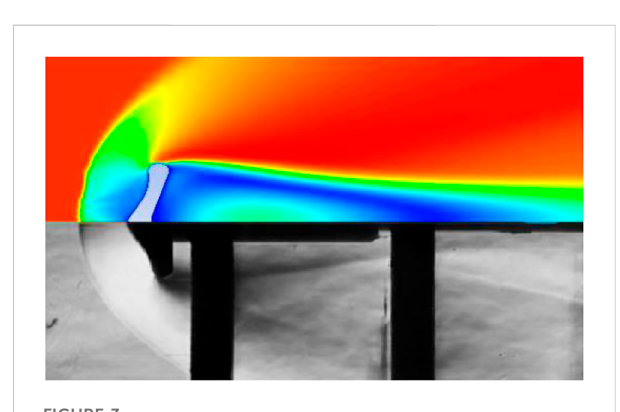
FIGURE 3 Comparison with Ma2 wind tunnel test